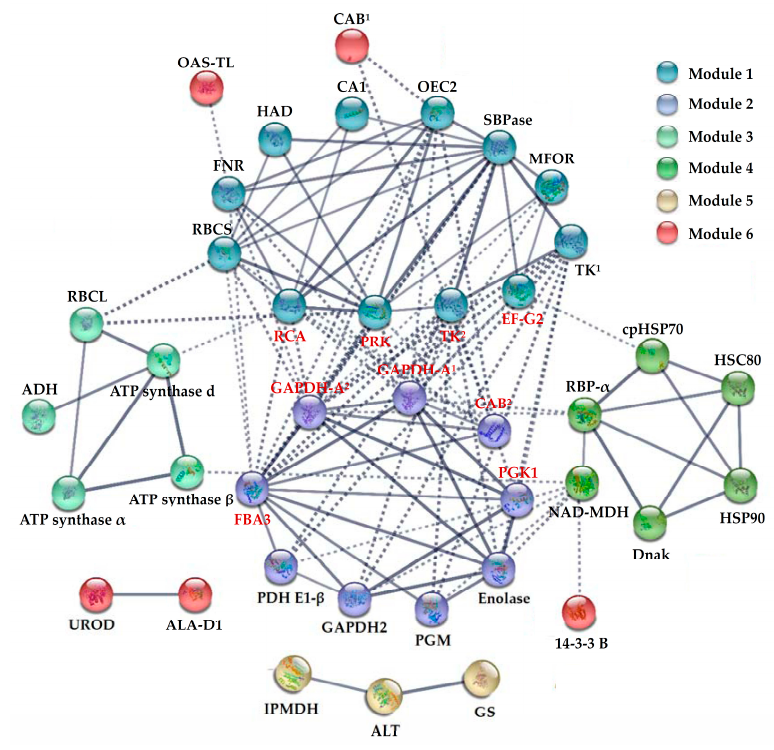
Figure 8. The protein–protein interaction (PPI) network in Populus simonii × Populus nigra leaves revealed by STRING analysis. A total of 81 H 2 O 2 -responsive proteins represented by 59 unique homologous proteins from Arabidopsis are shown in PPI network. Six main groups are indicated in different colors. The PPI network is shown in the confidence view generated by STRING database. Stronger associations are represented by thicker lines. The abbreviations refer to Table 1.